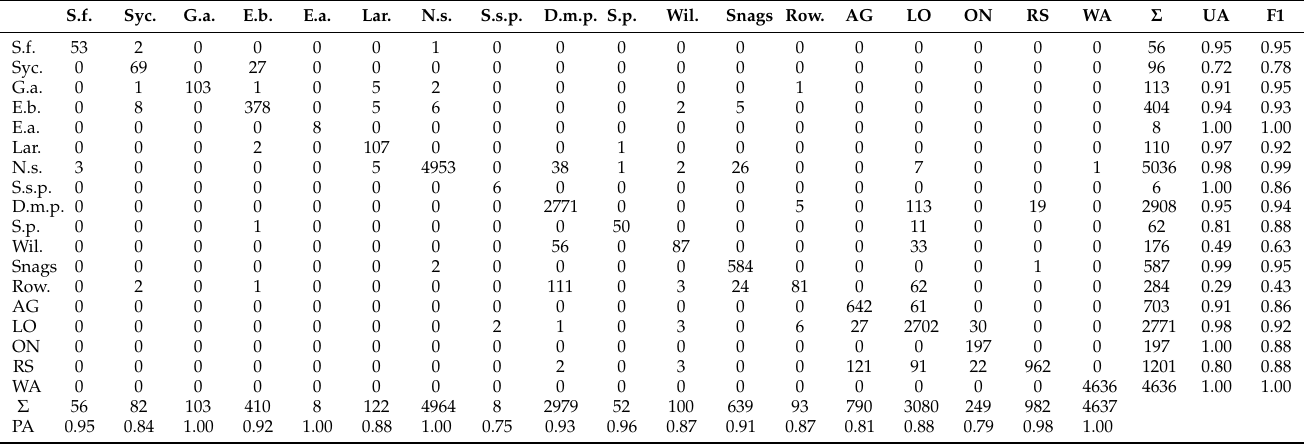
Table A1. Error matrix of obtained Sentinel-2, with topographic features and Support Vector Machine classification results. S.f.—silver fir ( Abies alba ); Syc.—sycamore ( Acer pseudoplatanus );